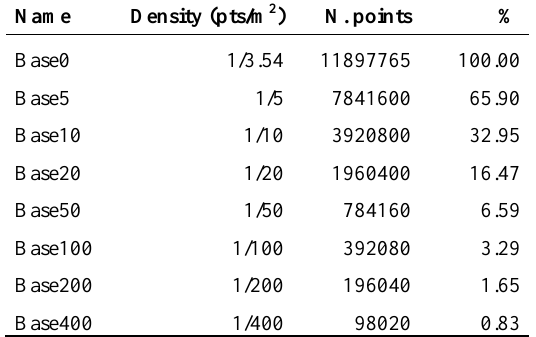
Table 2. Bardonecchia test site, input subsets